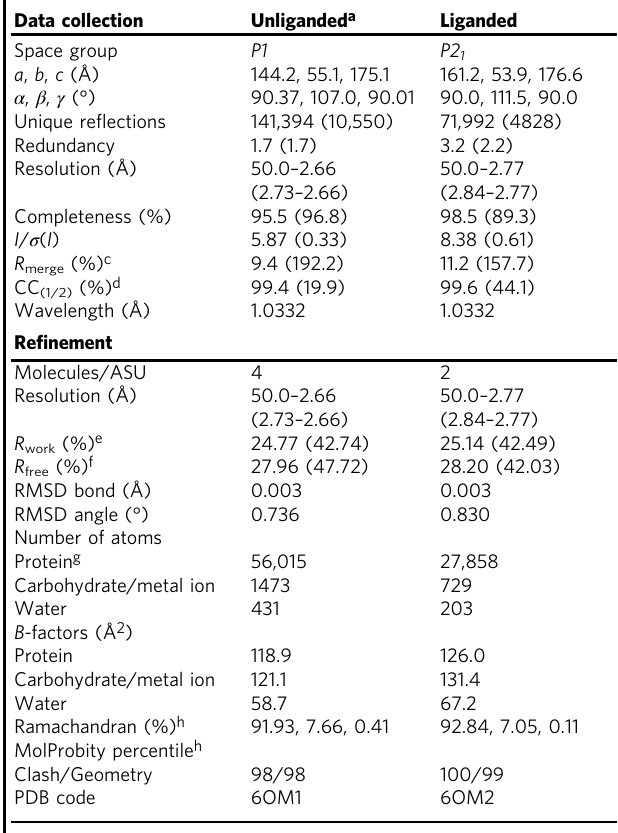
Table 1 α V β 8 headpiece data collection and re fi nement statistics a,b .